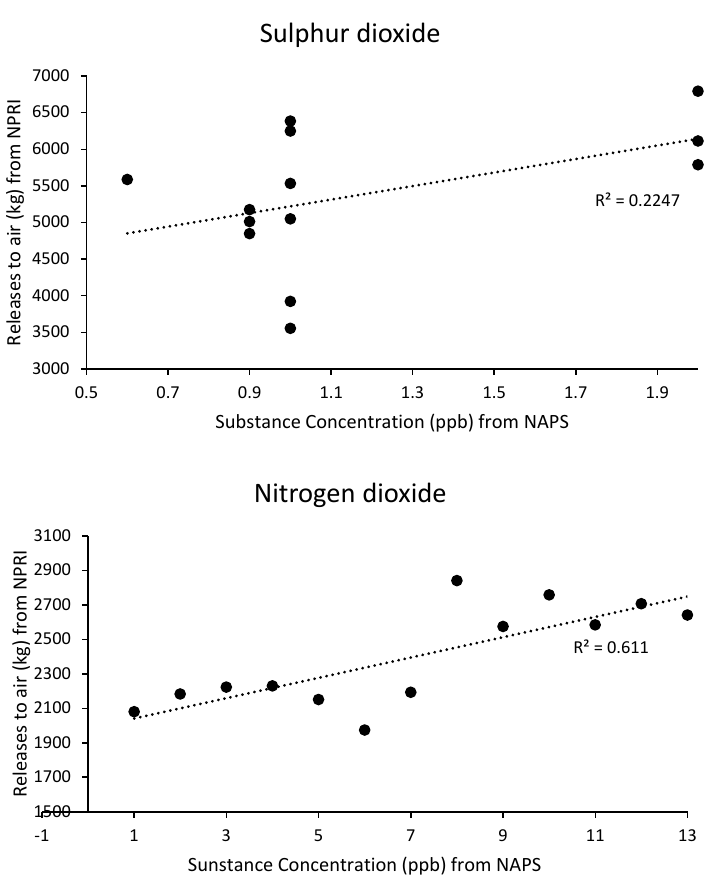
Figure 8. Comparison of NPRI and NAPS data for sulfur dioxide and nitrogen dioxide for a power generation facility from 2002 to 2015.